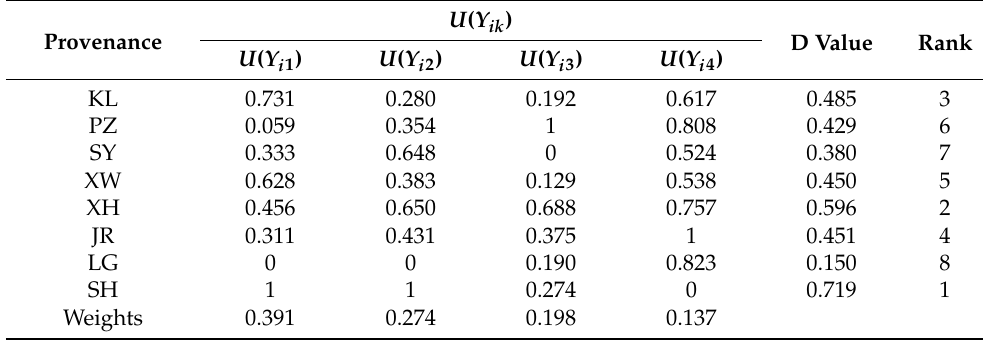
Table 10. The function value of the comprehensive indexes ( U ( Y ik )), weight ( W k ), and the compre- hensive evaluation value (D) of the different provenances under moderate drought stress.